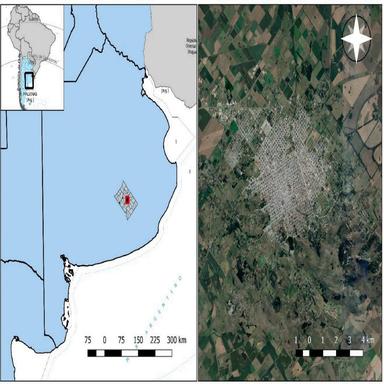
The county of Tandil (4935 km2 ) in Buenos Aires province with Tandil city in red (left) and the city in detail, with its square blocks in urbanized areas, typical of Latin American cities (right). (For interpretation of the references to colour in this figure legend, the reader is referred to the Web version of this article.)